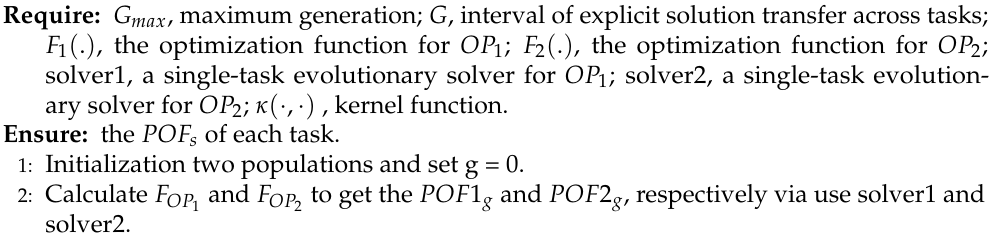
Algorithm 1 Framework of